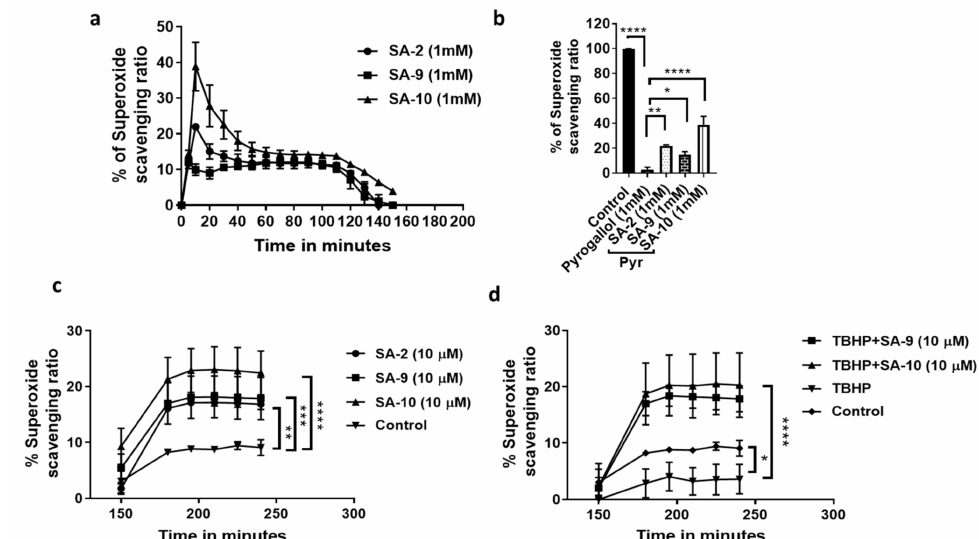
Figure 2. Superoxide scavenging ability of SA compounds in buffer and cells. ( a ) The % of superoxide scavenging response from 1 mM concentration of SA-2 , SA-9 , and SA-10 in pyrogallol (Pyr, 1 mM) induced superoxide induction assay at different time points in buffer. The AUC 0–2.5 h for SA-2, SA-9 , and SA-10 were 1592 ± 37.87, 1355 ± 42.62, and 2350 ± 69.26, respectively. ( b ) Comparison of the % ROS scavenging activity of SA-2, SA-9 , and SA-10 with control after 15 min of treatment of pyrogallol. ( c ) The superoxide scavenging ratio (%) after 18 h treatment of 10 µ M concentration of SA-2, SA-9 , and SA-10 to NTM-5 cell supernatant using pyrogallol induced superoxide induction assay at different time points. ( d ) The superoxide scavenging ratio (%) of 10 µ M concentration of SA-2, SA-9 , and SA-10 in NTM-5 cell supernatant. The cells were previously treated with 5.5 mM of TBHP for 30 min followed by SA compounds and incubated for 18 h. Control is untreated cells. Three technical replicates were used for each experiment and all experiments were repeated 2 times. * p < 0.05, ** p < 0.005, *** p < 0.001, **** p < 0.0001, One-way ANOVA for ( b ), and two-way